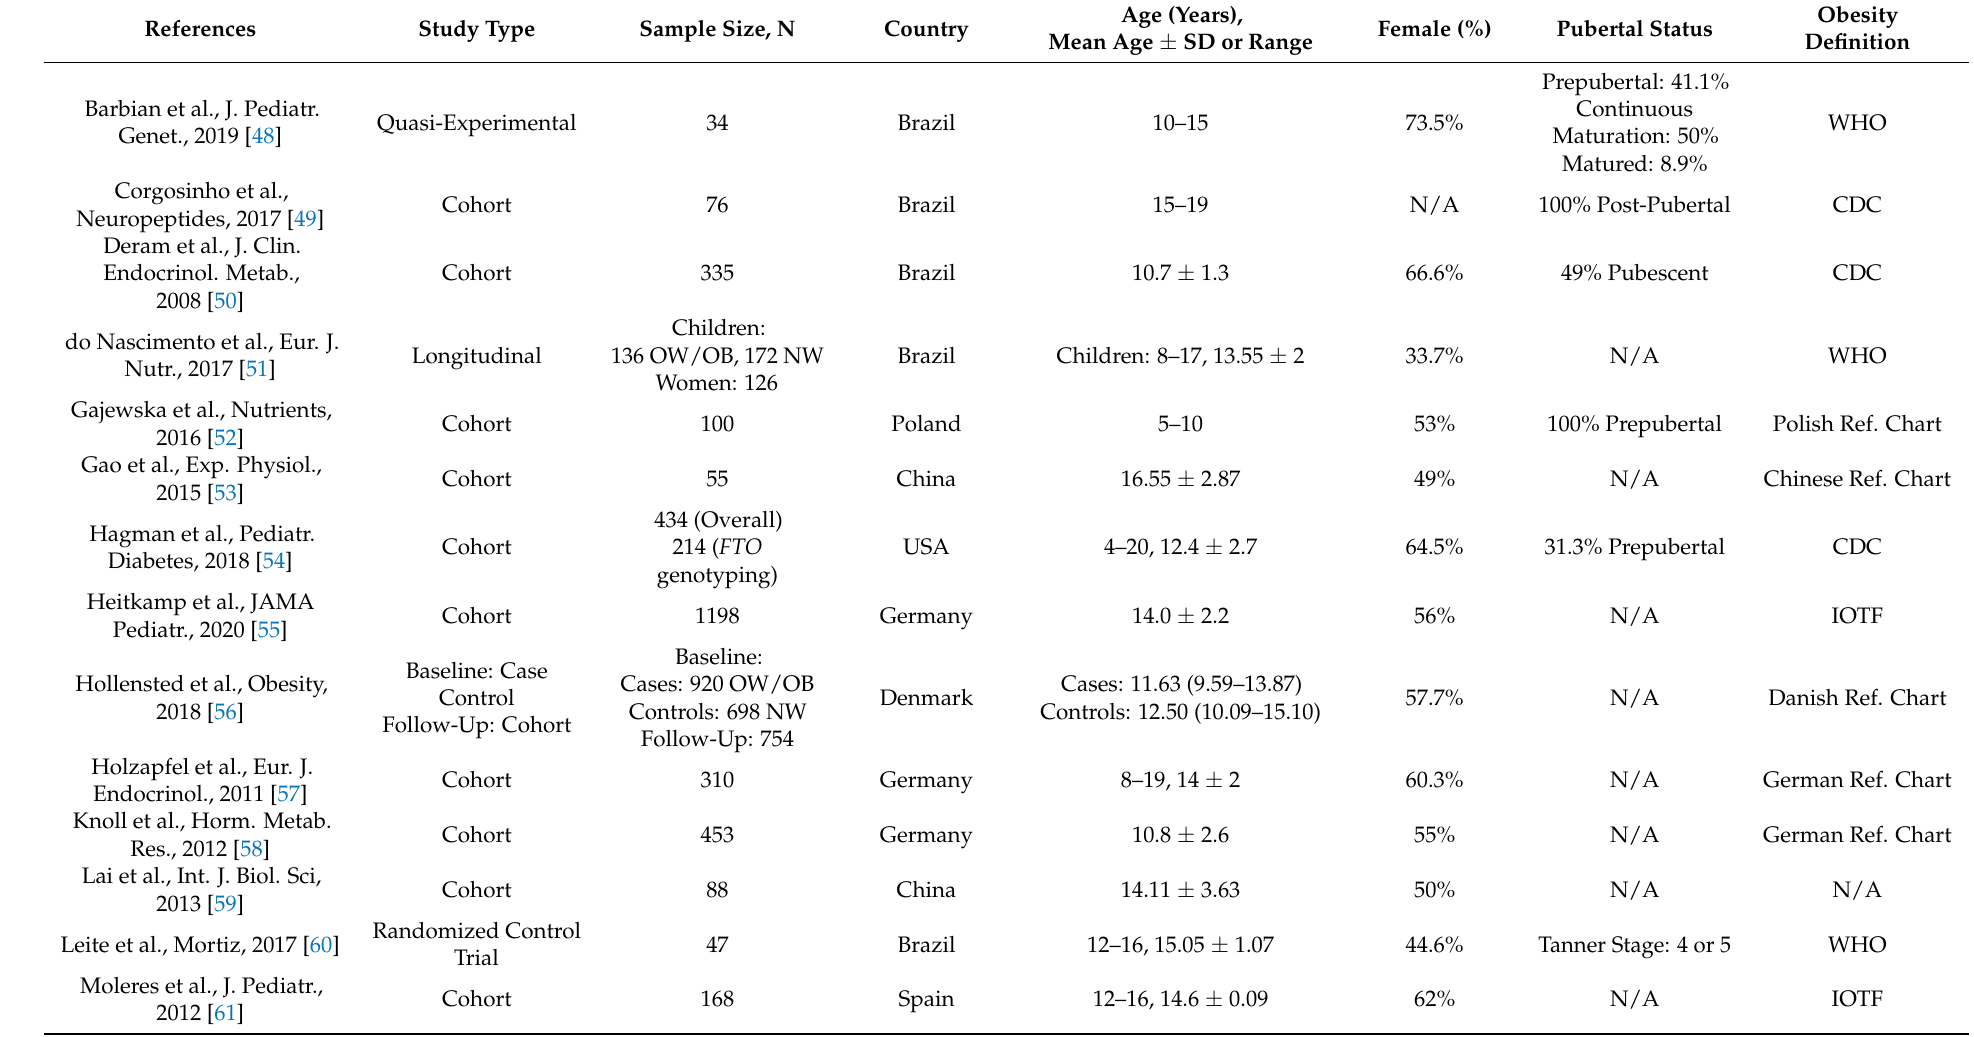
Table 3. General characteristics of the interventional studies included in the systematic